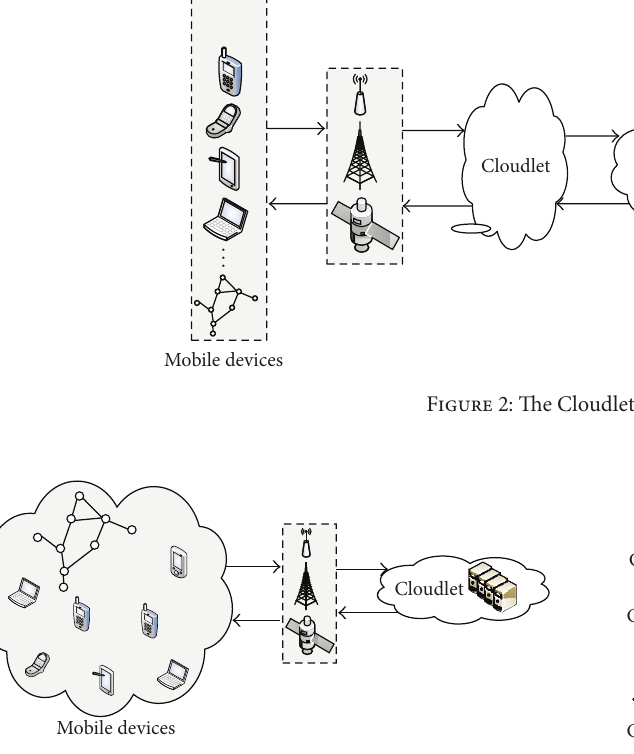
Figure 3: The architecture of the hybrid local mobile cloud model. Figure 4: The general working process of